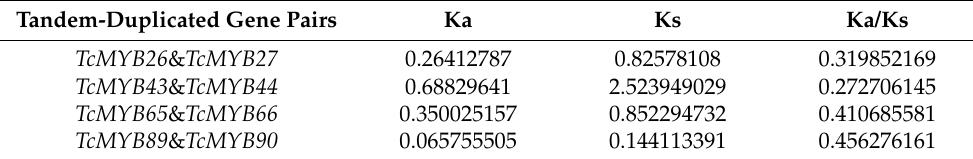
Table 1. The Ka, Ks and Ka/Ks values of the Theobroma cacao tandem-duplicated gene pairs. Tandem-Duplicated Gene Pairs Ka Ks